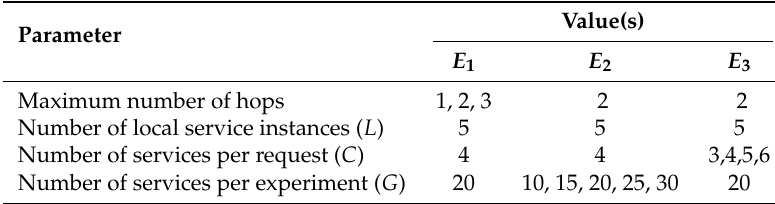
Table 3. Parameters varying according to the evaluations.